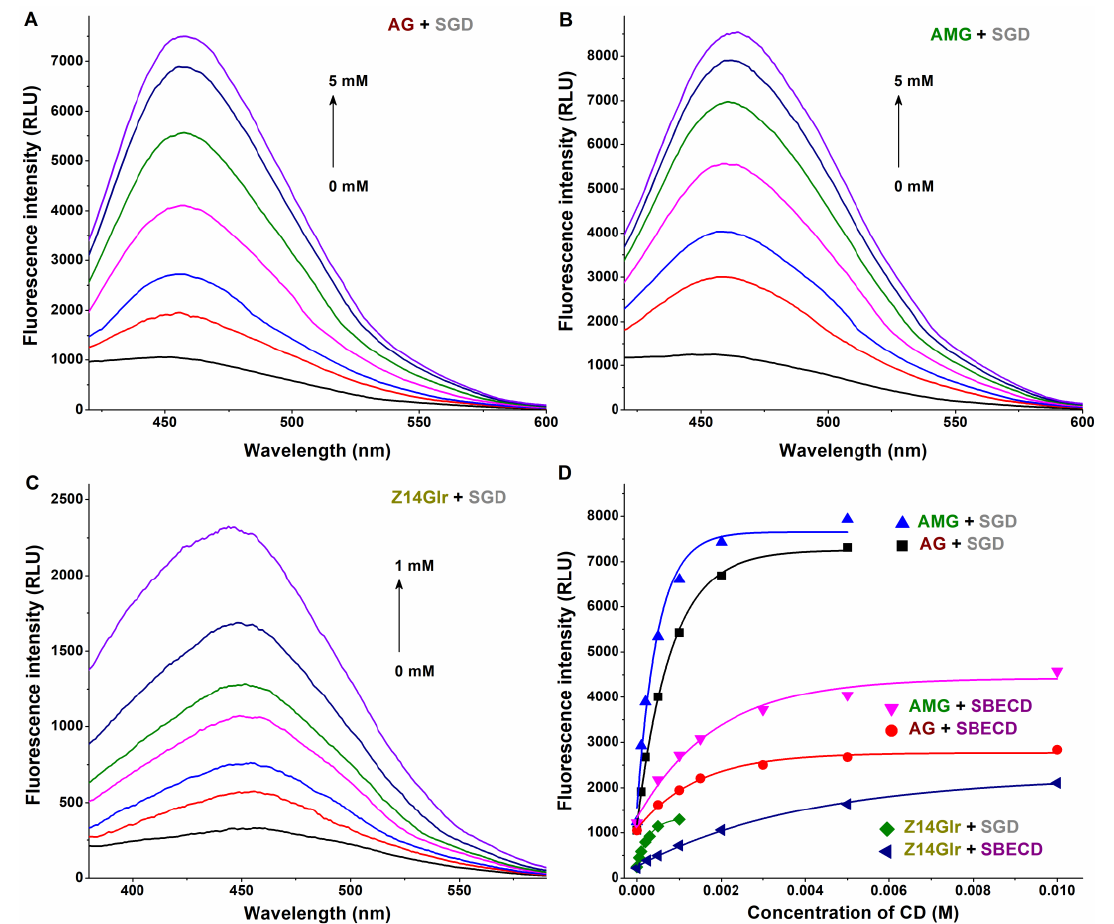
Figure 6. Representative fluorescence emission spectra of AG - SGD ( A ), AMG - SGD ( B ), and Z14Glr - SGD ( C ) complexes. Effects of SBECD and SGD on the fluorescence emission signals ( D ) of AG, AMG, and Z14Glr in sodium acetate buffer (0.05 M, pH 5.0; mycotoxins concentration: 1 μM; n = 3; λ ex = 335 nm for AG and AMG, and 315 nm for Z14Glr; λ em = 455 nm for each mycotoxin; AG, alternariol - 3 - glucoside; AMG, alternariol - 9 - monomethylether - 3 - glucoside; Z14Glr, zearalenone - 14 - glucuronide; SBECD, sulfobutylether - β - cyclodextrin; SGD, sugammadex).